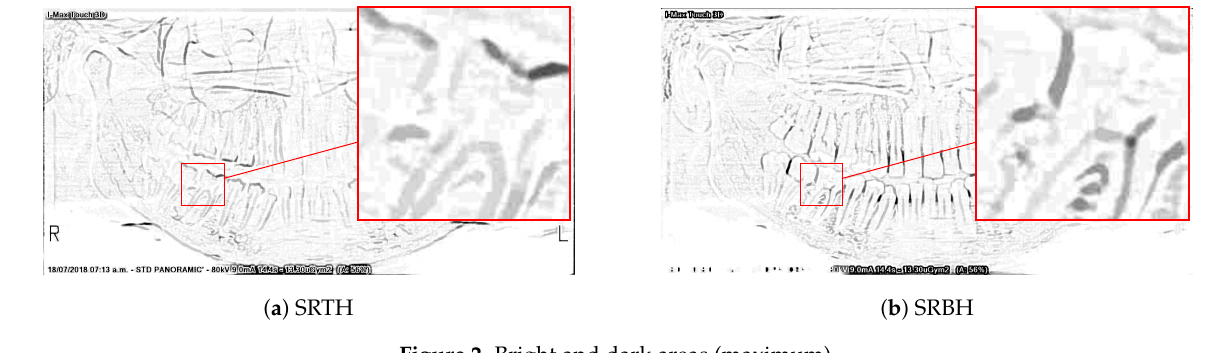
Figure 2. Bright and dark areas (maximum).